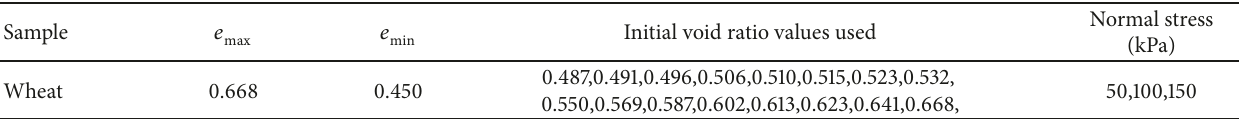
Table 2: Properties for shear tests of